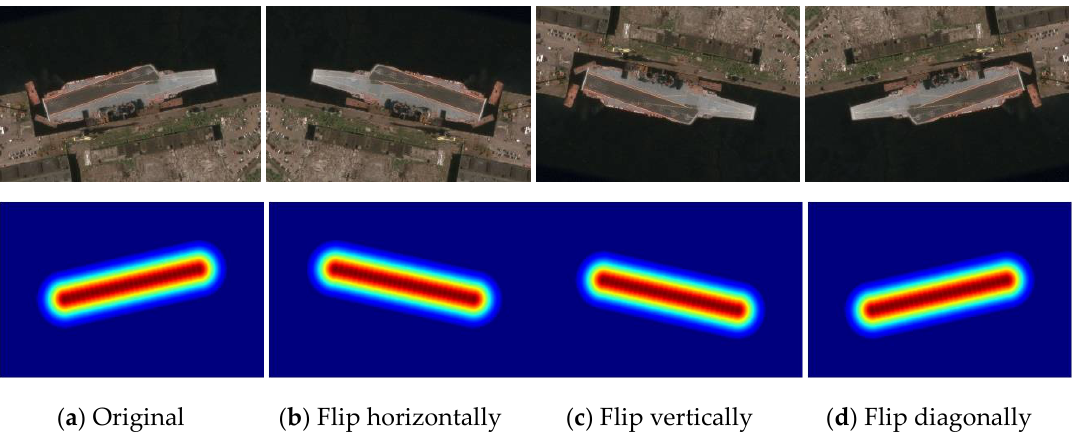
Figure 6. Data augmentation. The top row is the remote sensing image, and the bottom row is the ground truth. ( a ) Original, ( b ) Flip horizontally, ( c ) Flip vertically, ( d ) Flip diagonally. ( b ) Flip horizontally, ( c ) Flip vertically, ( d ) Flip